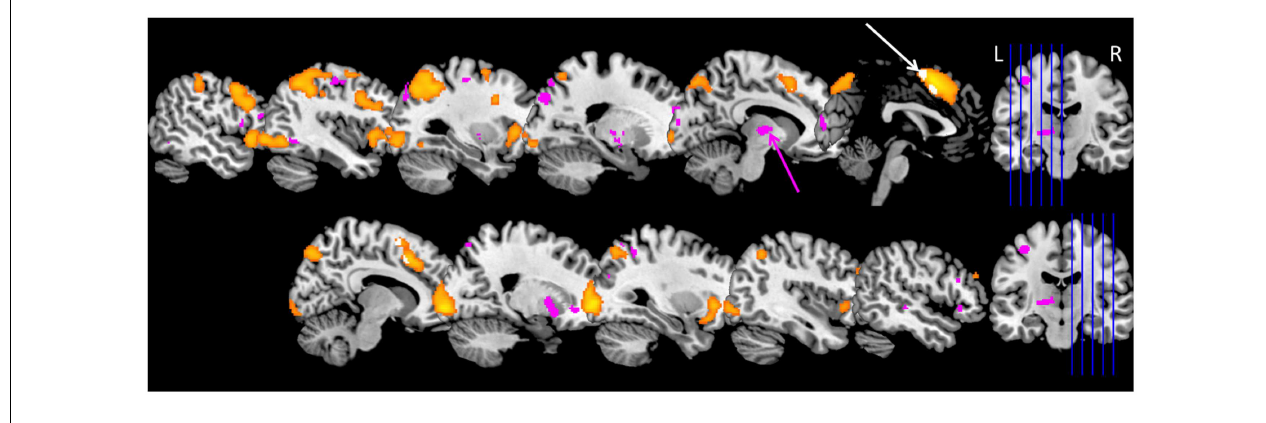
a pink arrow.The white arrow marks areas within the orange activation cluster in the anterior cingulate cortex and adjacent medial prefrontal cortex where KLS patients had less activation compared to the healthy control group. Data include 18 KLS patients and 18 matched controls